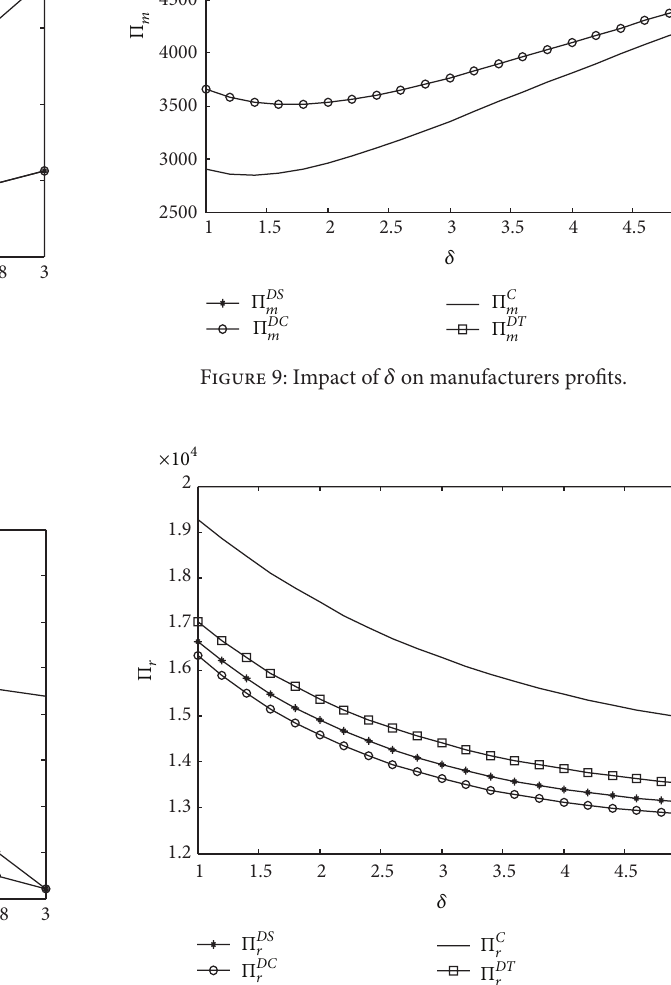
Figure 10: Impact of 𝛿 on retailers